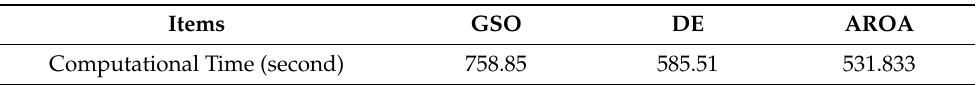
Table 5. Average computational times of the AROA, GSO, and DE for the third scenario for the IEEE 33-distribution system .